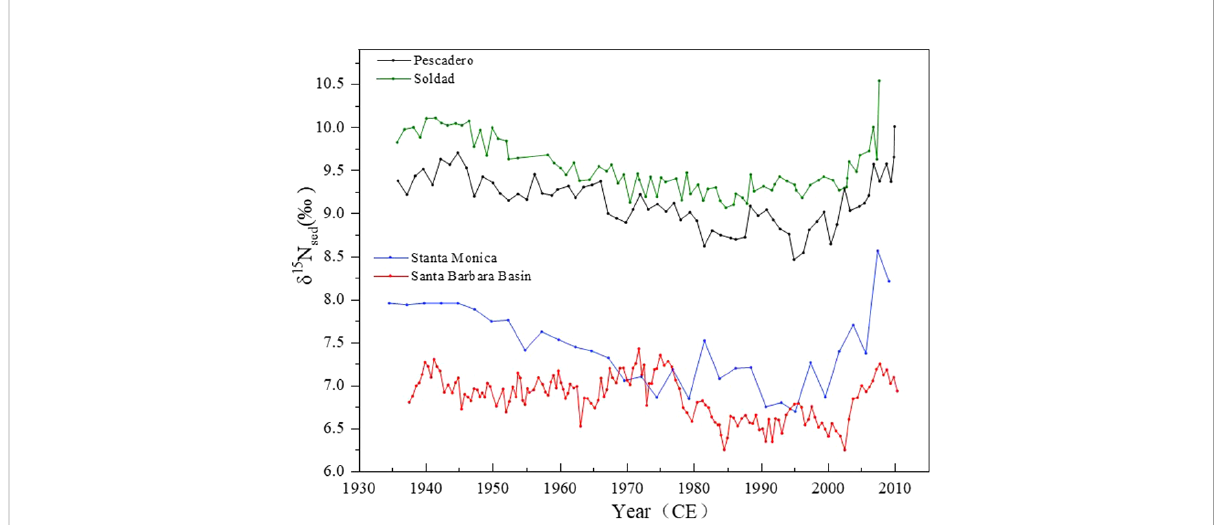
FIGURE 5 Bulk organic d 15 N from four sediment core sites along the North American margin: Soledad (Deutsch et al., 2014), Pescadero (Deutsch et al., 2014), Santa Monica Basin (Davis et al., 2019), and Santa Barbara Basin (this study). Locations of core sites are showing in Figure